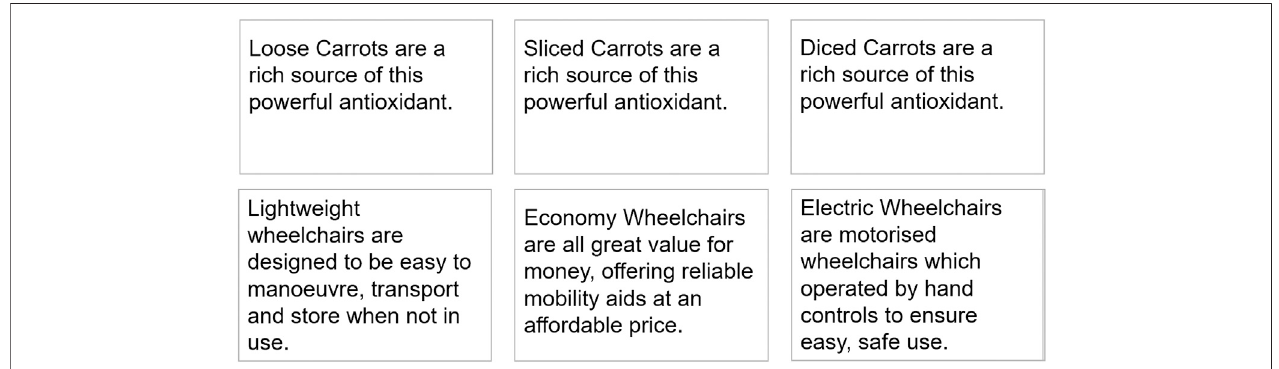
FIGURE 8 | Samples of product descriptions used in the study.